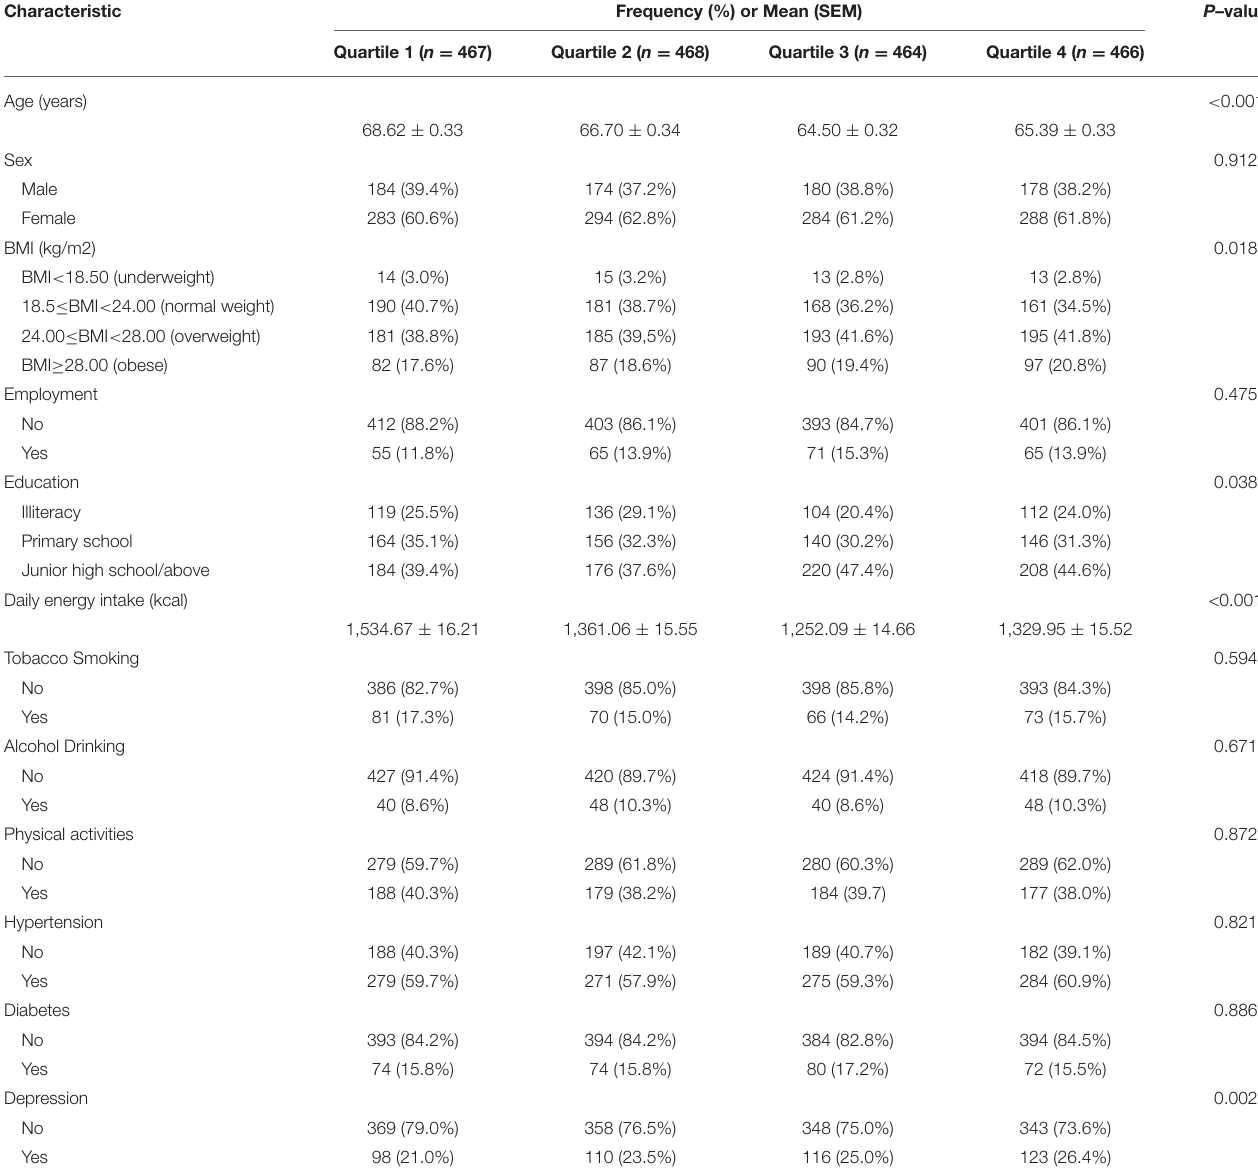
TABLE 1 | Baseline characteristics of the study population(CCSNSD cohort data, N = 1865). Characteristic